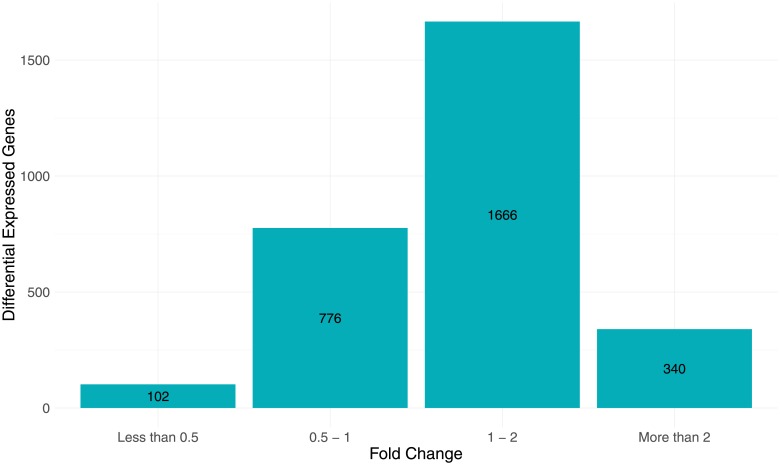
Number of genes differentially expressed in head kidney induced by vaccination, one day after immunization.Control fish (n = 6) versus vaccinated fish (n = 24).